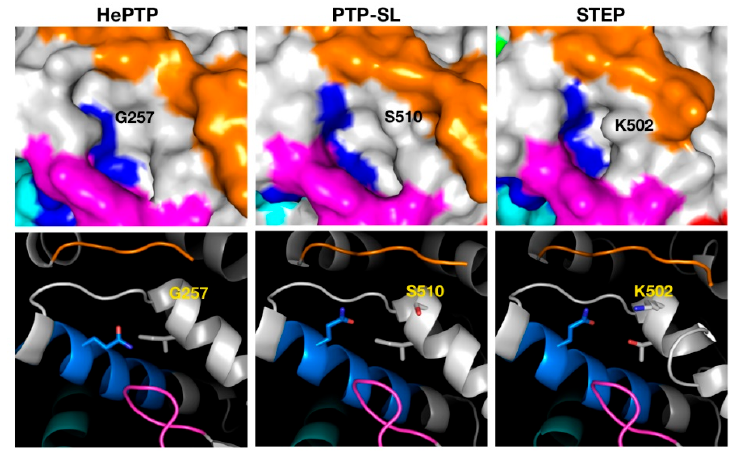
Figure 3. Structural analysis of the pocket associated with cluster 4 across the three KIM-PTPs (HePTP, PTPSL and STEP). In the top panels the three KIM-PTPs are represented as surfaces, whilst in the bottom panels they are shown in cartoon format, with key residues shown as sticks and labelled accordingly. In both panels the colouring is as follows: KIM-PTP specific motifs K3 (orange), K5 (magenta), K6 (cyan), and K7 (blue).